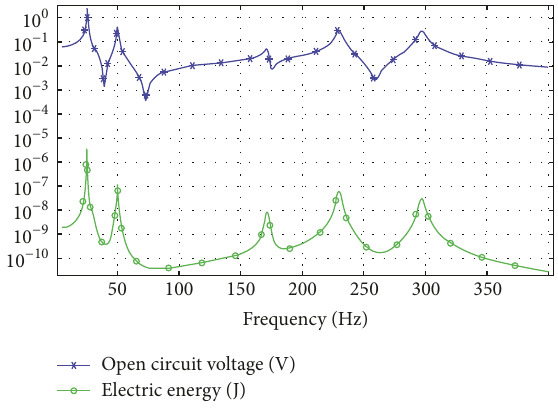
Figure 6: Electrical characteristics of the harvester.